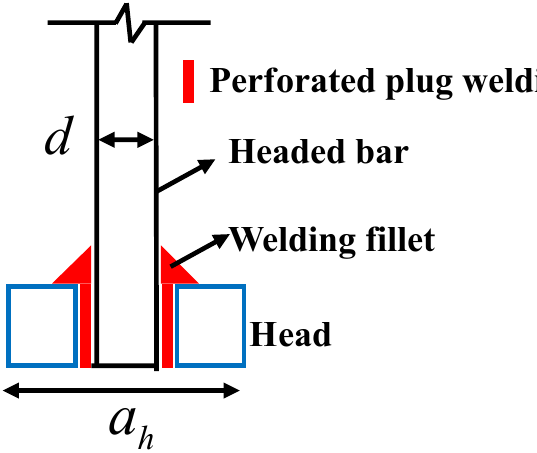
Figure 24. Connection between head and steel bar.